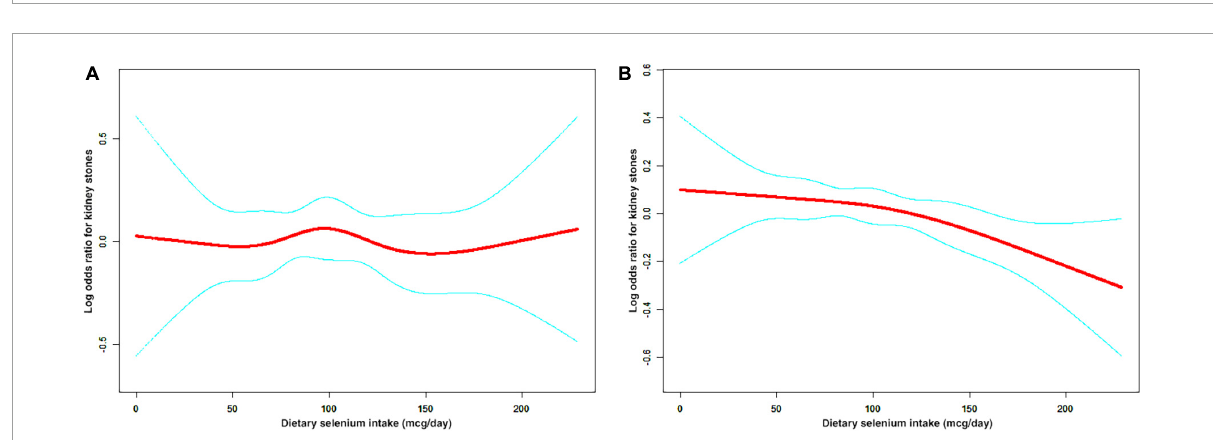
FIGURE5 The non-linear relationship between dietary selenium intakes and the risk of kidney stones in stratified analysis by BMI. (A) BMI < 25.0 group (B) BMI ≥ 25.0